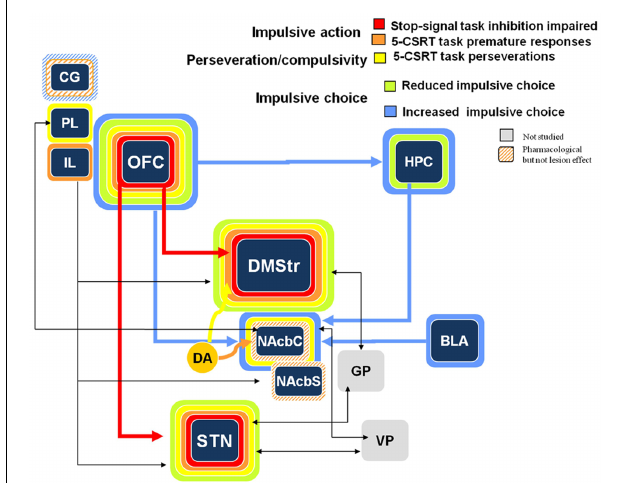
FIGURE 3 | Schematic representation of the impulsive action, perseveration/compulsivity, and impulsive choice processes in the stop task, the 5-CSRTT (premature responses and perseverative responses) and the delay-discounting task from lesion and pharmacological manipulations. Colored bands surrounding each structure highlight the impulsive-like effect of the lesion of the given structure. Hatched–shaded bands indicate no effect of excitotoxic lesion, but an effect under pharmacological manipulation or other conditions). Gray structures indicate that no information is available. Arrows materialize anatomical connections between regions. CG, cingulate cortex; PL, pre-limbic cortex; IL, infra-limbic cortex; OFC, orbito-frontal cortex; HPC, hippocampus; DMStr, dorso-medial striatum; NAcbC, nucleus accumbens core; NAcbS, nucleus accumbens shell; GP, globus pallidus; BLA, basolateral amygdale; STN, subthalamic nucleus;VP, ventral pallidum (from Eagle and Baunez,